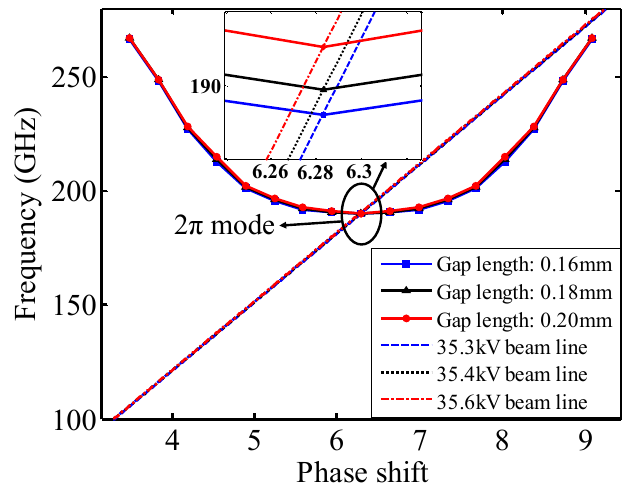
Figure 4. Dispersion curves of the EIO circuit with different gap lengths.